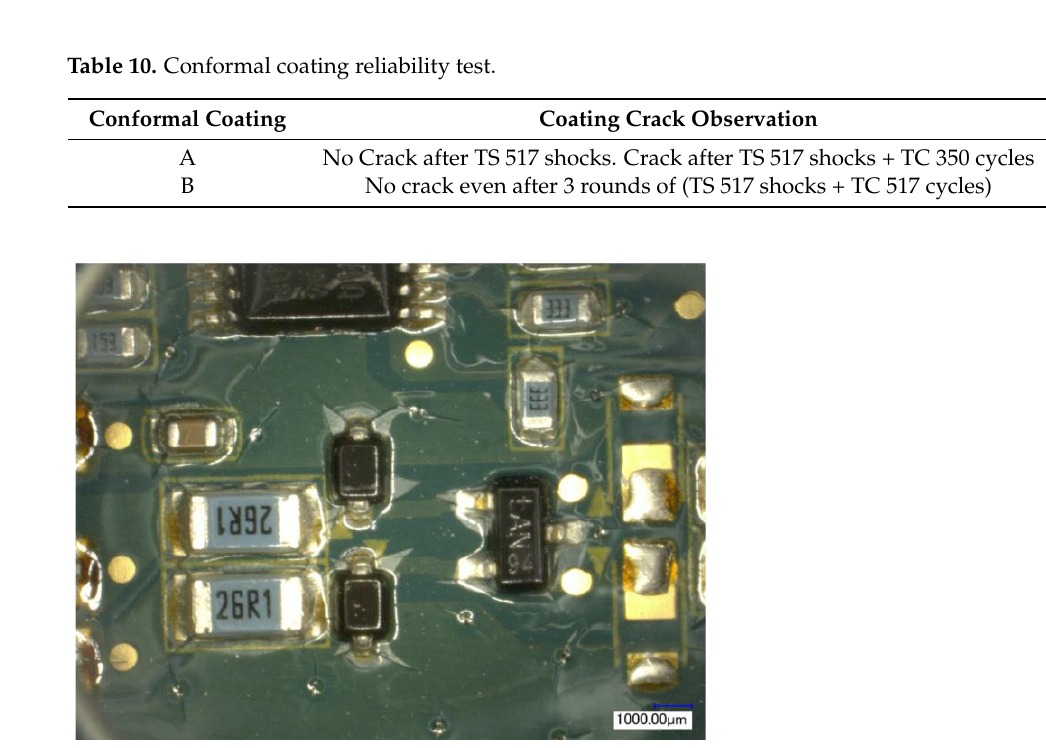
Figure 17. PCB coated with Conformal Coating A, showing cracks after 517 cycles of thermal shocks and 350 cycles of thermal exposure, as described in the text.